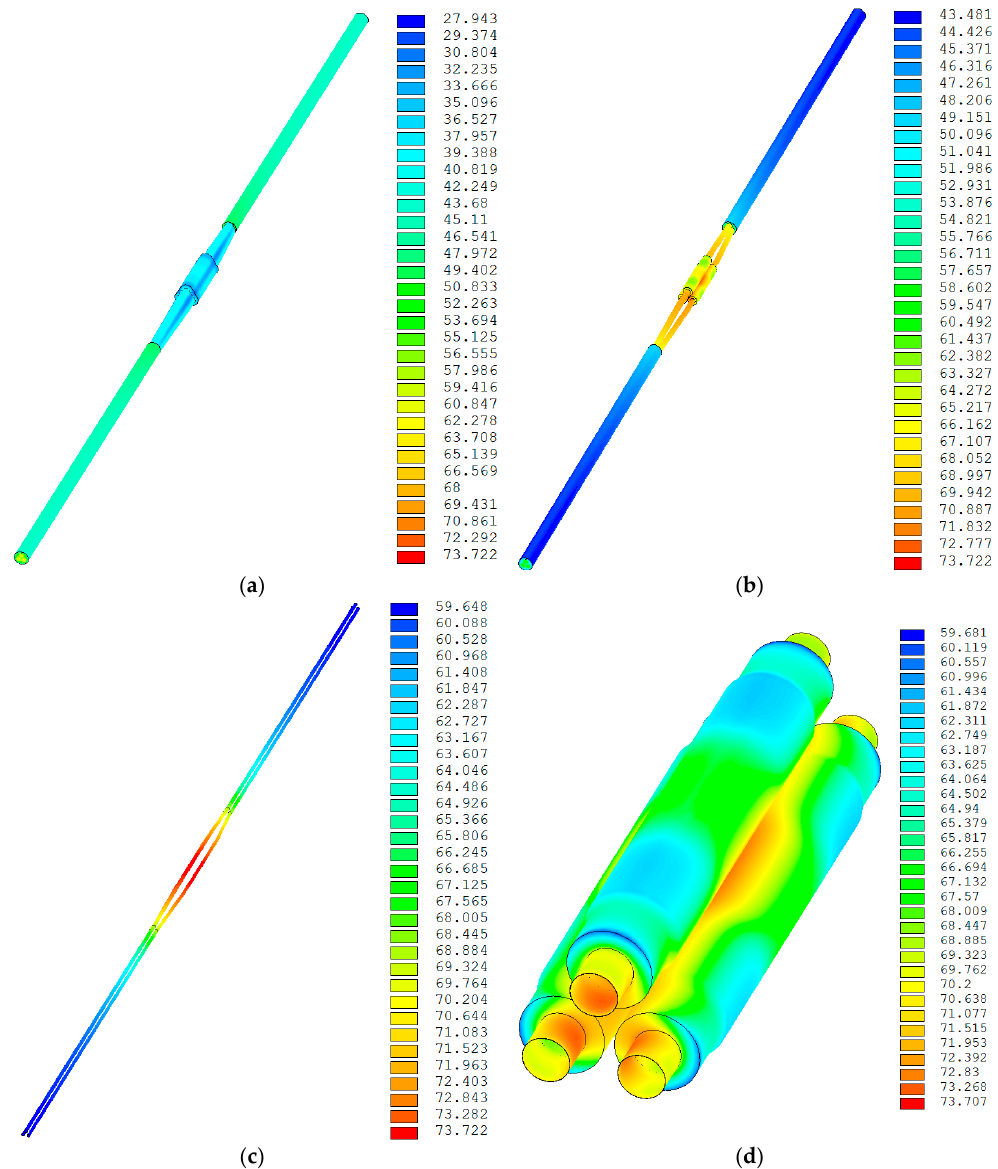
Figure 6. Steady-state temperature profile of three-core cable joint. ( a ) The entire body; ( b ) The body without armor wrap and air; ( c ) Core conductor; ( d ) Prefabricated rubber.